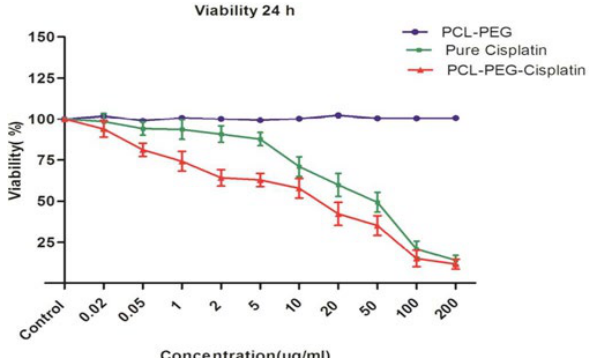
Fig. 6.a: The results of treatment with dilutions of block copolymers, pure and copolymer containing cisplatin in 24 hours